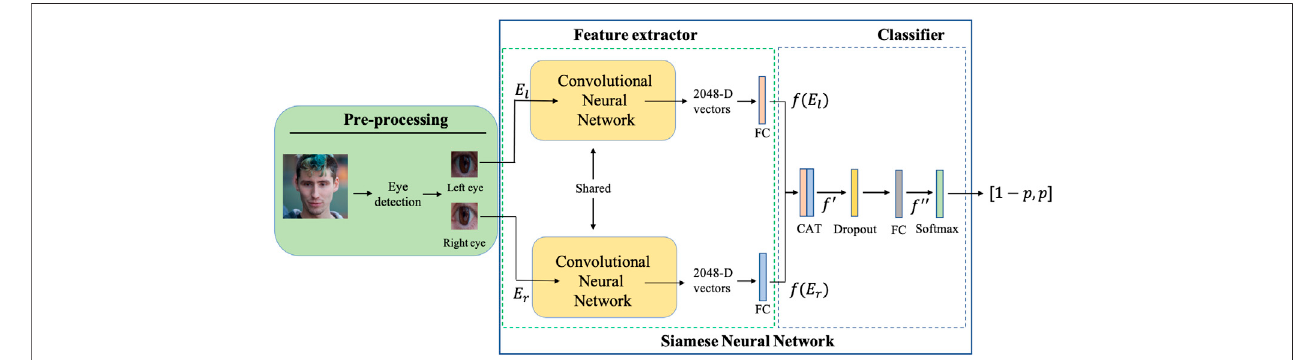
FIGURE 1 | The proposed Siamese Eyes-based detector of GAN-generated face images.